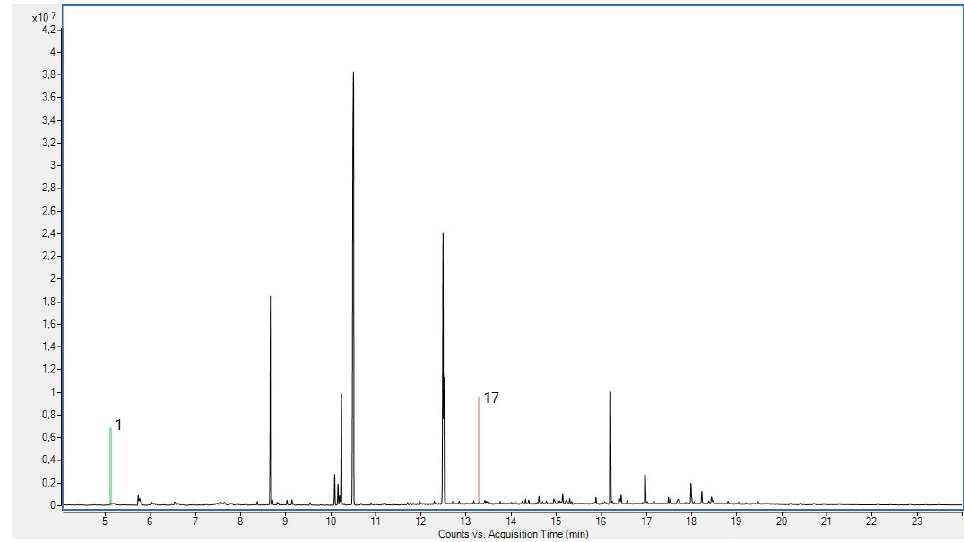
Figure 5 . Chromatogram of DCM extraction of sample Y with # ID. Figure 5. Chromatogram of DCM extraction of sample Y with # ID.